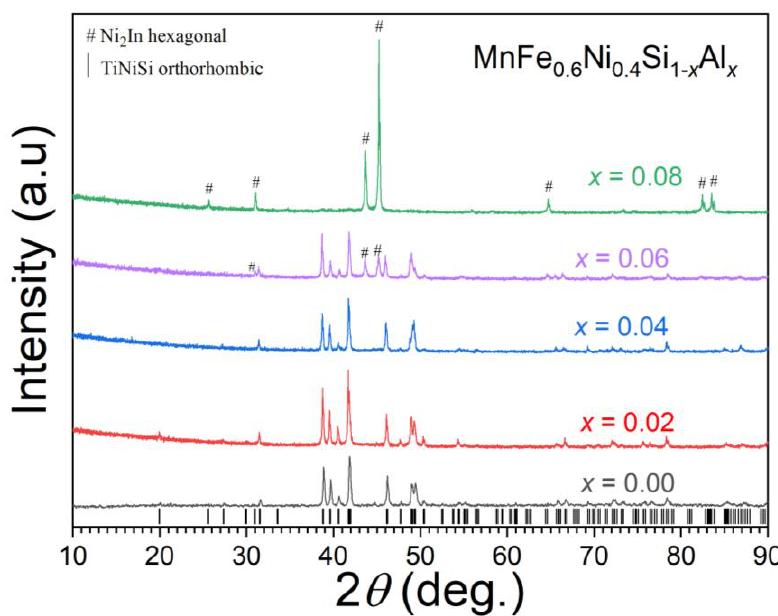
Figure 1. X-ray diffraction patterns at room temperature for MnFe 0.6 Ni 0.4 Si 1 -x Al x compounds (quenched from 1100 °C). Vertical lines and octothorpes mark out the reflections from orthorhombic TiNiSi-type and hexagonal Ni 2 In-type structures, respectively. Table 1. Refined room temperature lattice parameters, unit cell volume, and phase fractions for